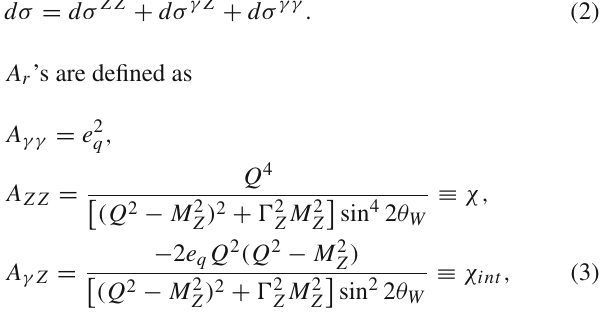
momenta of the outgoing hadrons.The symbol r can be γ γ , Z Z and γ Z , for EM, weak and interference terms, respec- tively. A summation over r in Eq. (1) is understood, i.e. the total cross section is given